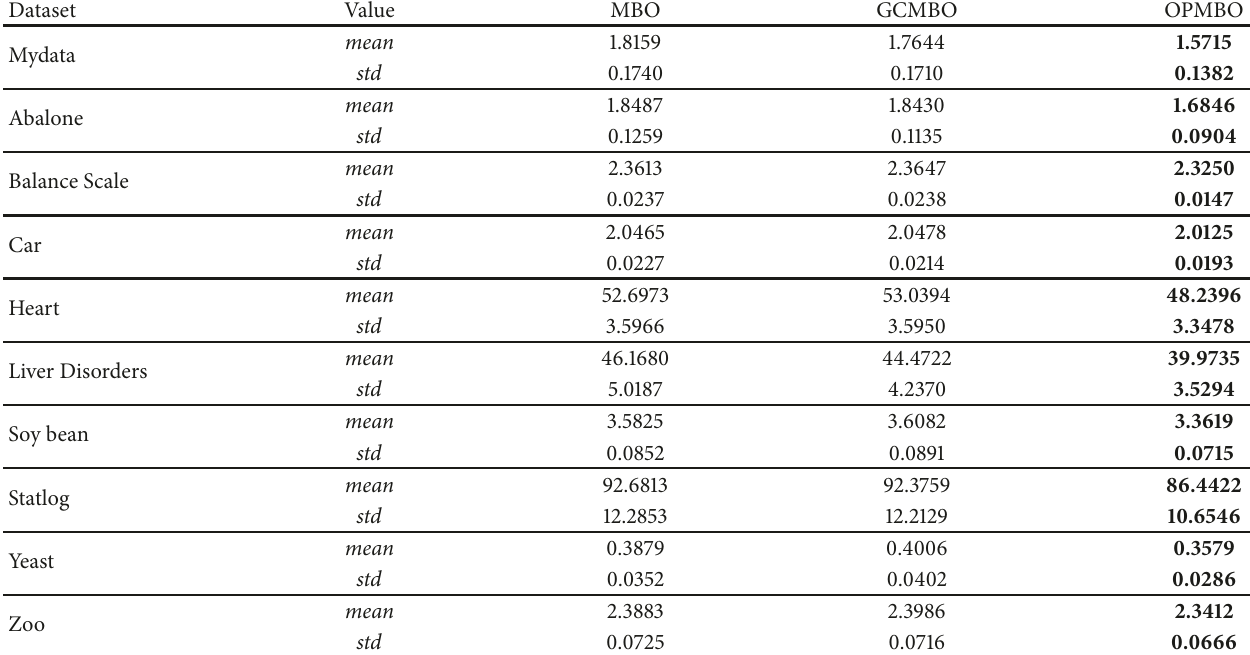
Table 10: The comparison results of clustering optimization on the three different MBO